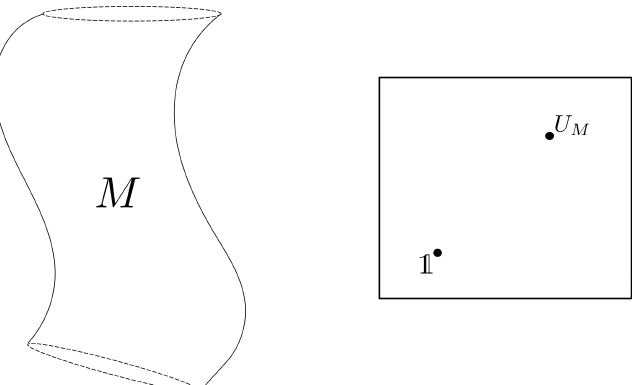
Figure 3: Left: M is a Euclidean or Lorentzian manifold with two boundaries from which operators can be defined. Right: The space of all such operators, which are unitary when M is Lorentzian. U is the operator whose matrix elements are calcu- M lated by the path integral on M